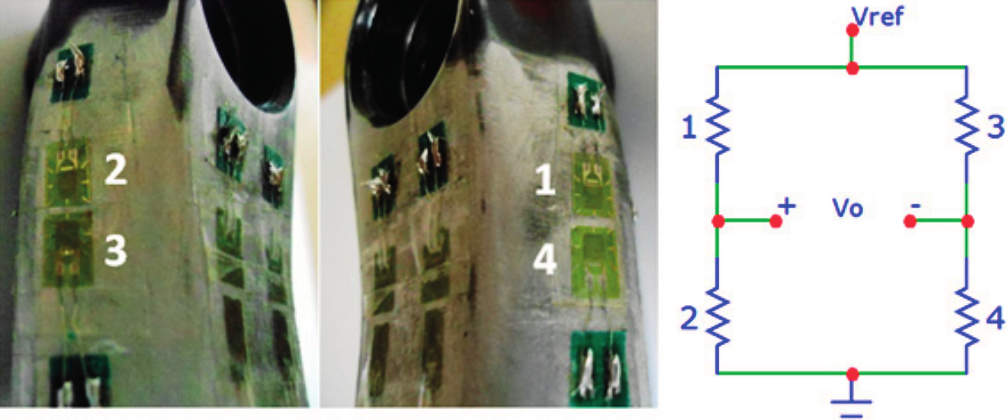
Figure 5. 350.6 Ω strain gauges and bridge